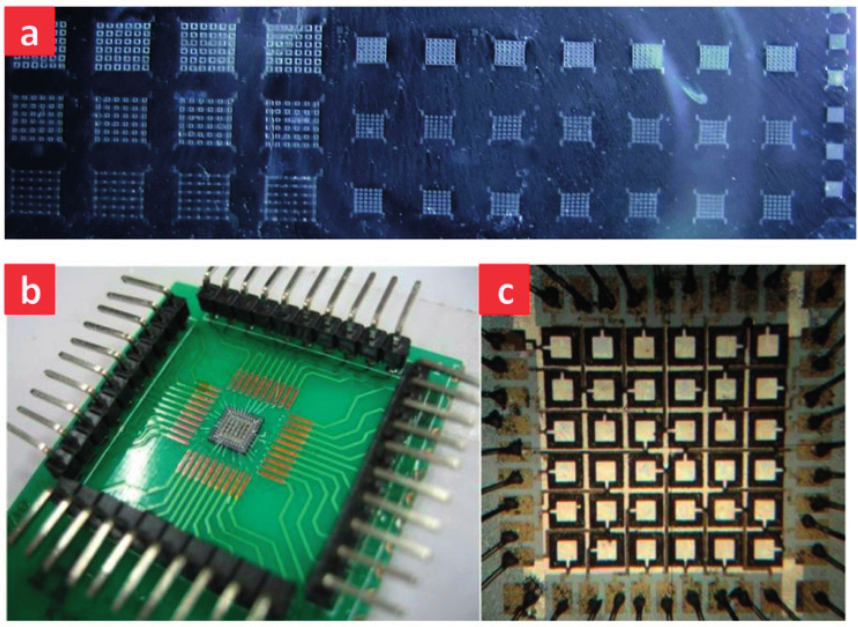
Figure 13. Photographs of ( a ) 2D PMUT arrays; ( b ) a packaged array used for testing; and ( c ) a 6 × 6 2-D PMUT matrix array with element size 200 μ m × 200 μ m and total area less than 2 mm × 2 mm